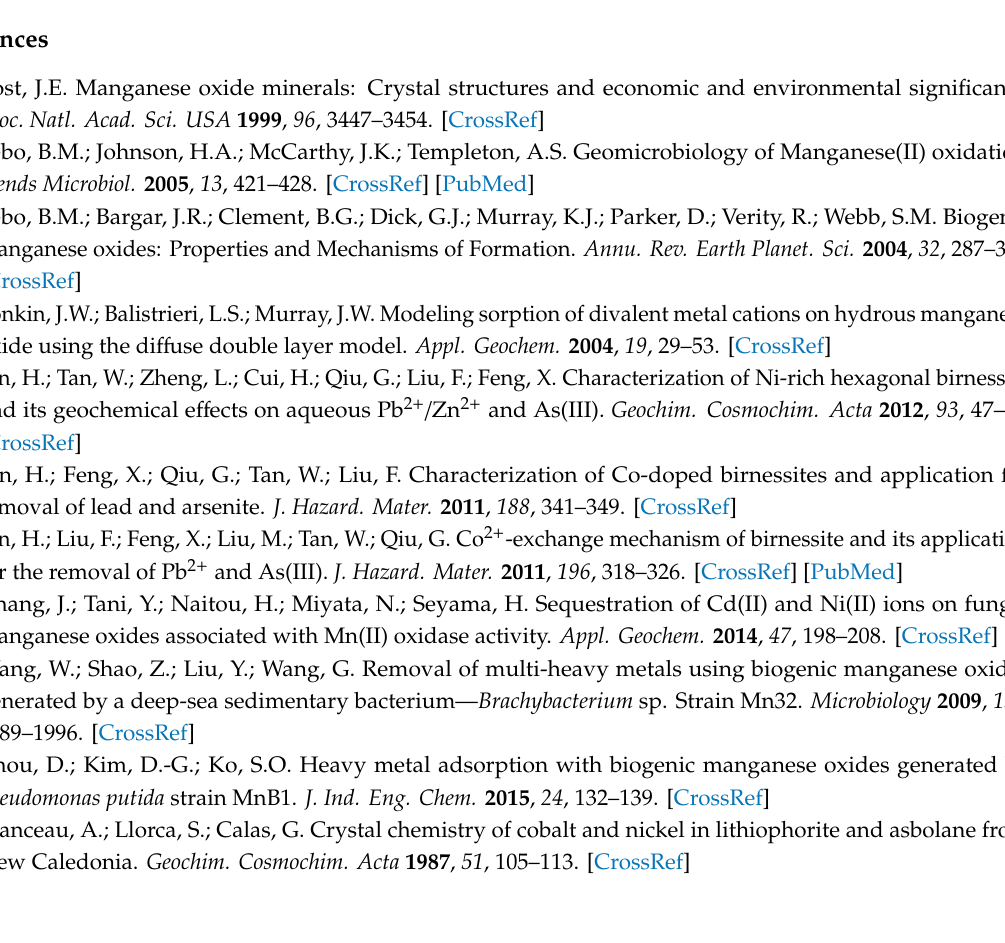
Figure S1: Pictures on experimental details and XRD pattern of asbolane; Figure S2: Transmission Electron Microscopy (TEM) pictures and XRD patterns of desautelsite obtained in a previous study for comparison purposes; Figure S3: Field aspect and XRD patterns of birnessite-rich precipitate found in the Reoc í n pit